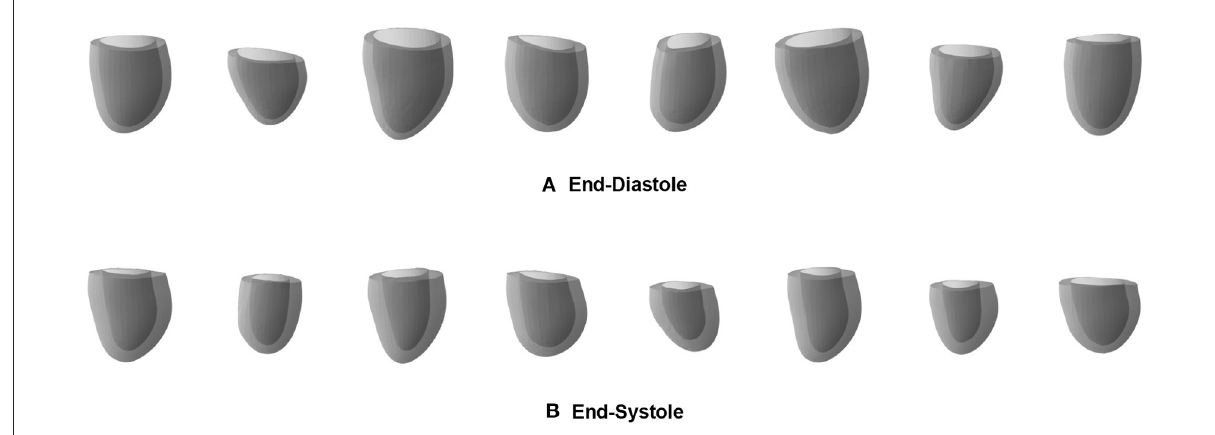
FIGURE6 Sample meshes generated by separate pretrained ED (A) and ES (B) mesh VAEs.